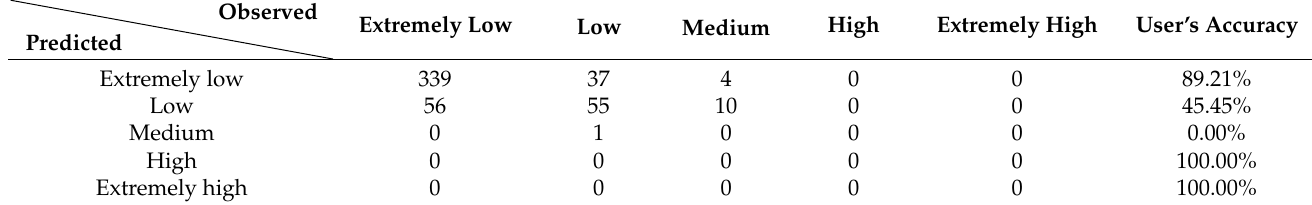
Table 7. Allocation confusion matrix of Ca.